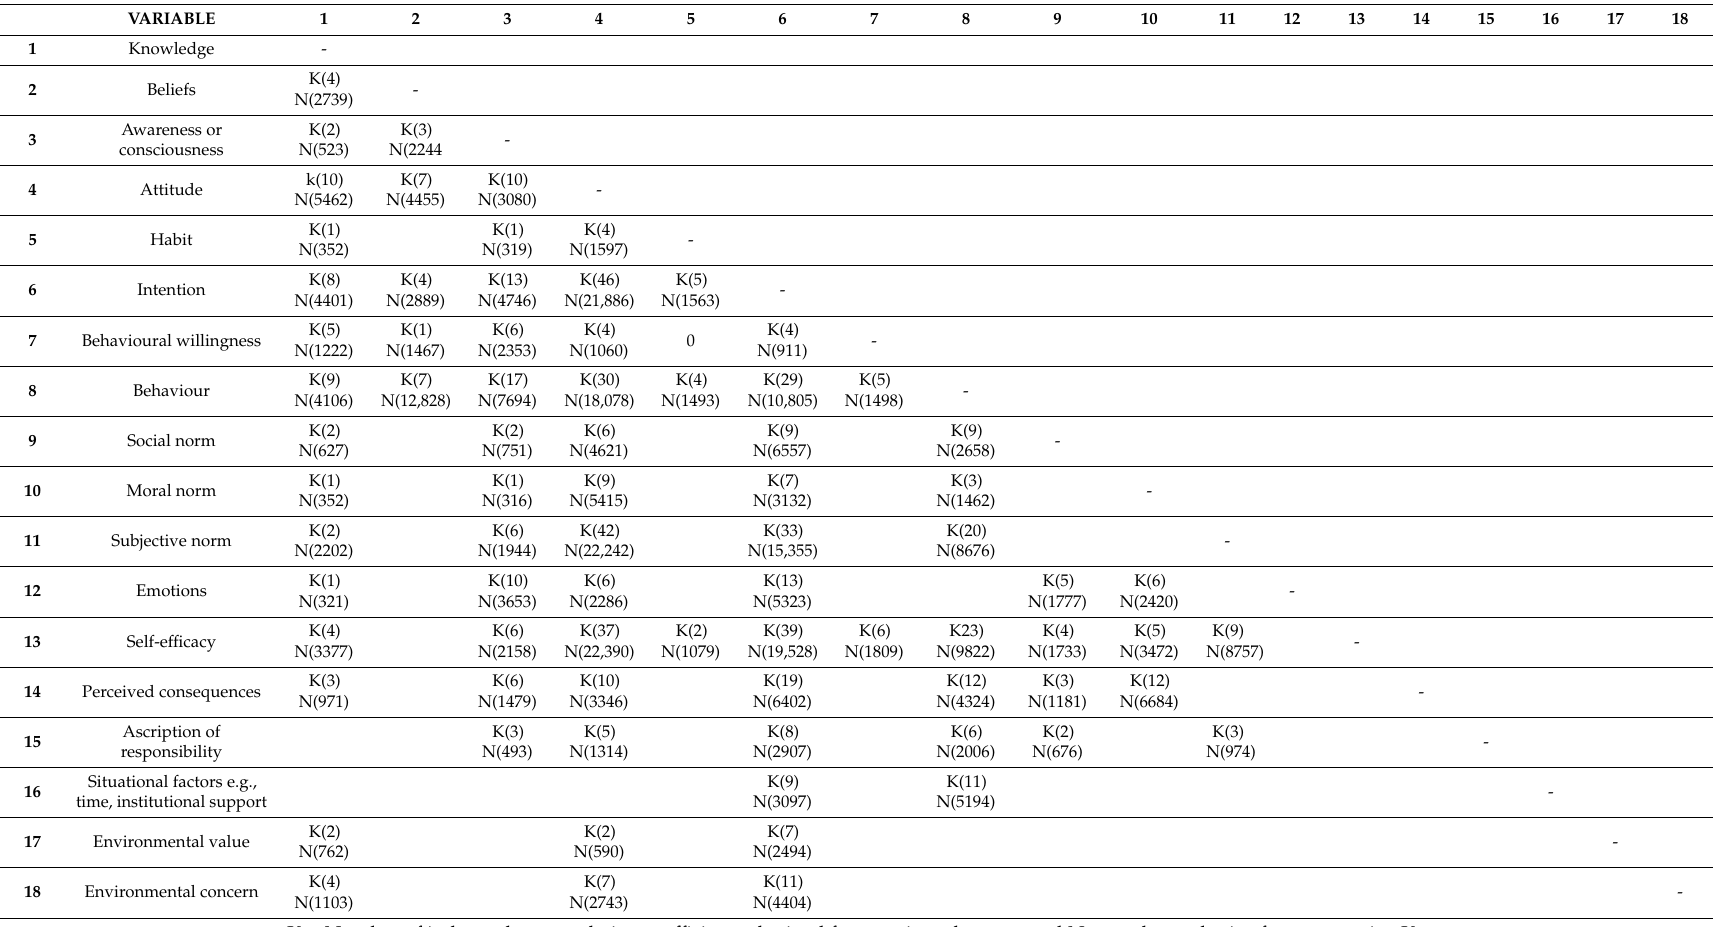
Table 4. Number of independent primary bivariate correlation coe ffi cients and pooled total sample